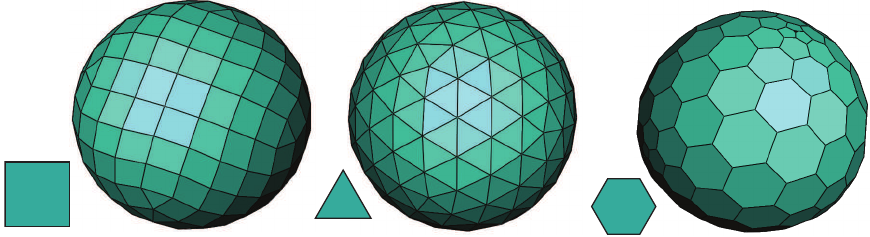
Figure 3. Quadrilateral, triangular and hexagonal cells on spherical